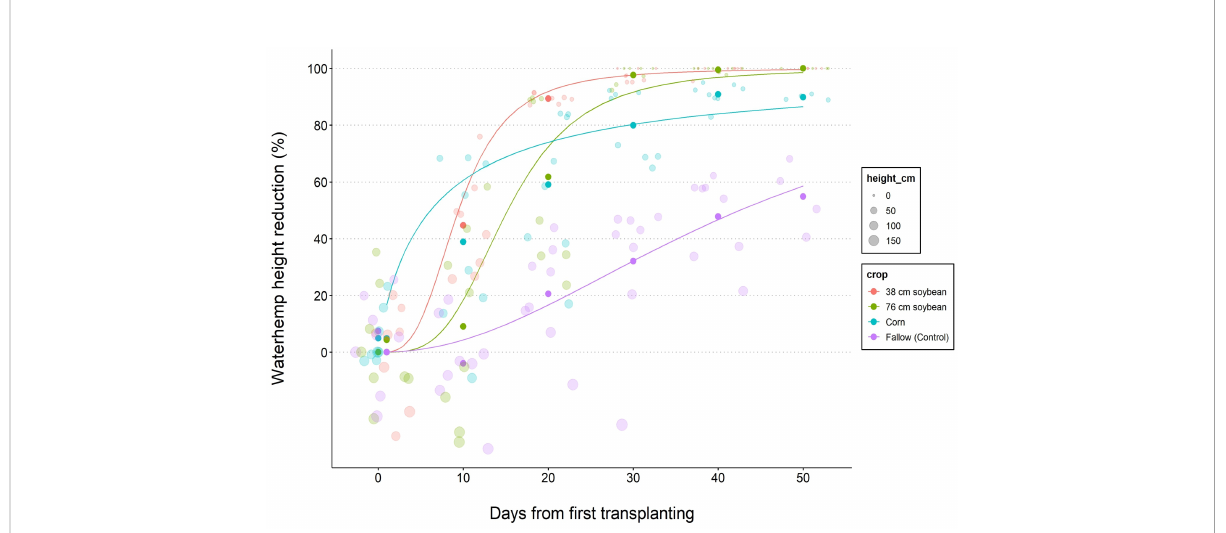
FIGURE 3 Nonlinear regression 3-parameter Weibull 2 models depicting reduction of waterhemp height for 38 (narrow) and 76 (wide) cm row spacing soybeans, corn (76 cm row spacing), and fallow treatment. Data lines represent the best model fi t for cumulative waterhemp height regressed on the days from the fi rst transplant timing. Waterhemp transplanting started on June 14 in 2019, and June 9 in